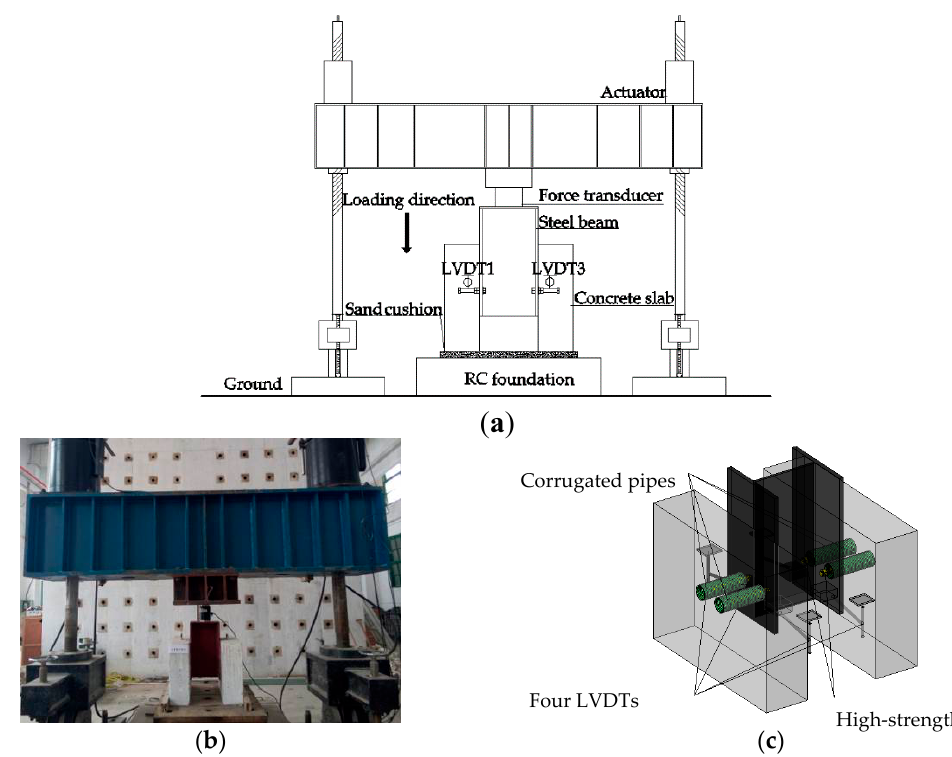
Figure 3. Test setup: ( a ) push-off test; ( b ) experimental setup photograph; ( c ) arrangement of linear variable displacement transducers (LVDTs).